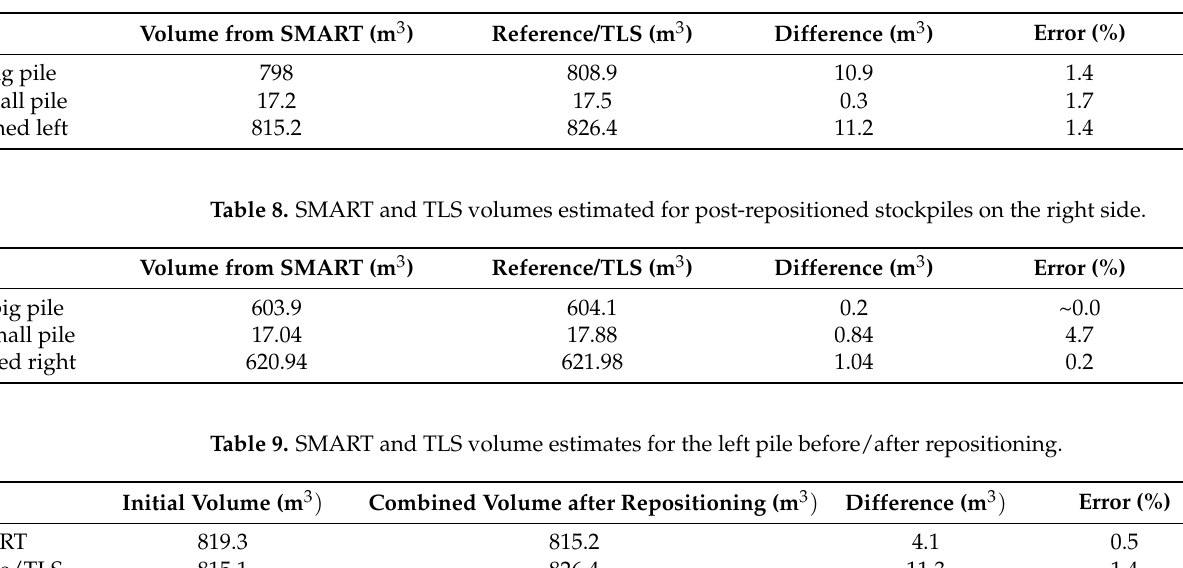
repositioning test at the Lebanon Facility. Initial left and right piles are highlighted in red and blue,